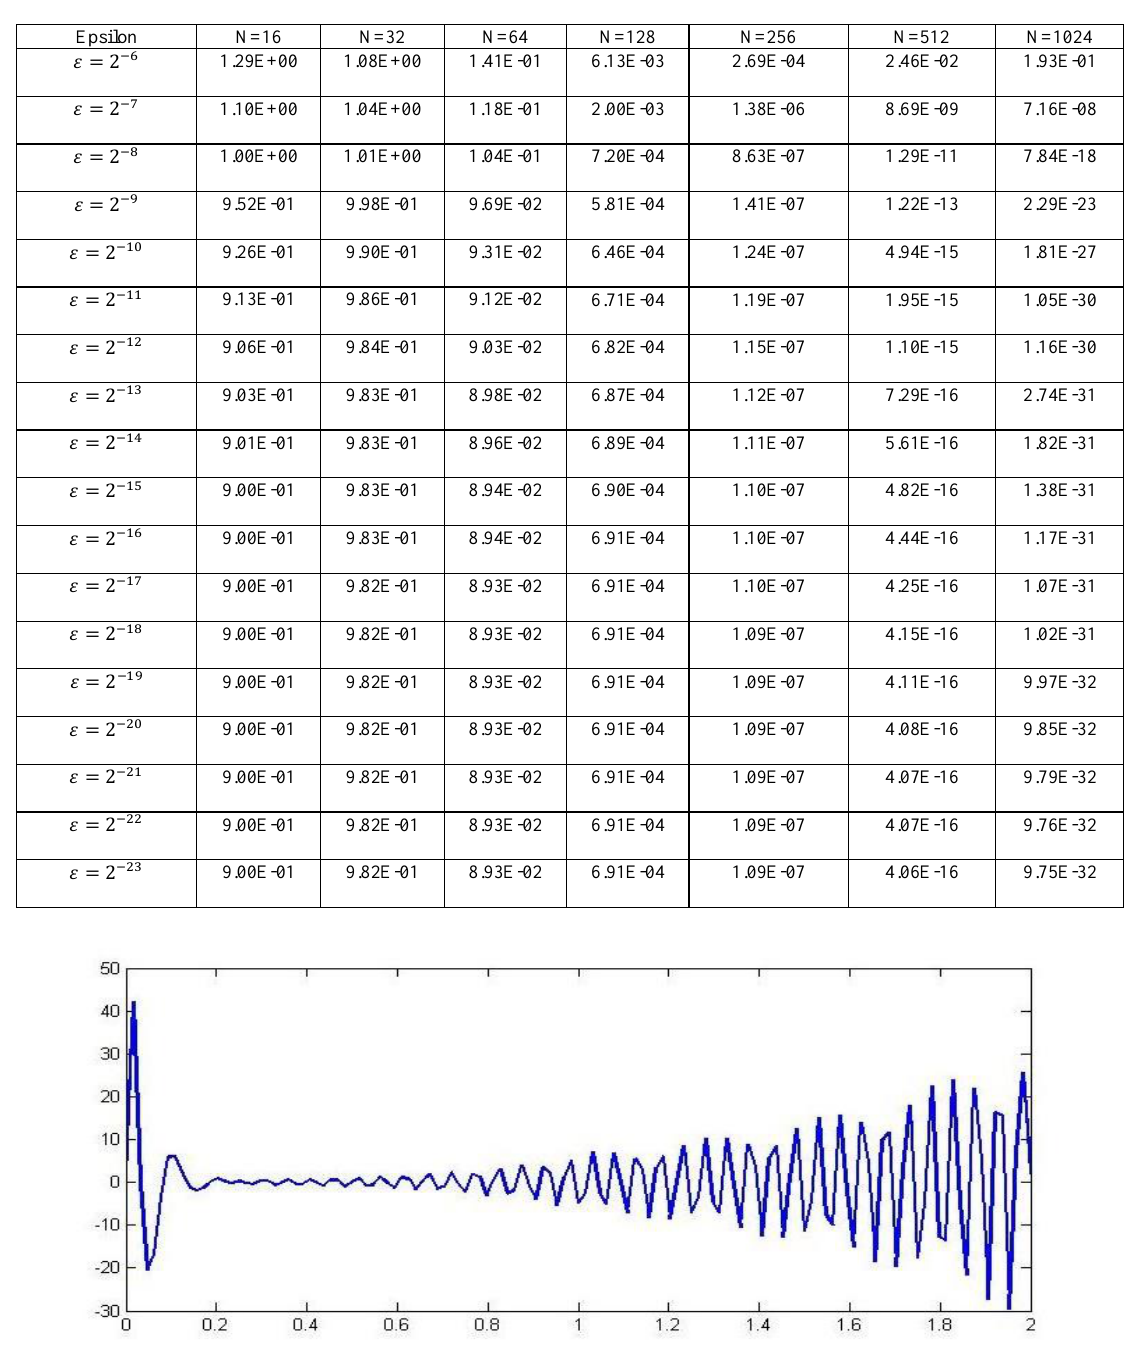
Figure 1. Graph of solution of Example 1 for N =128 and